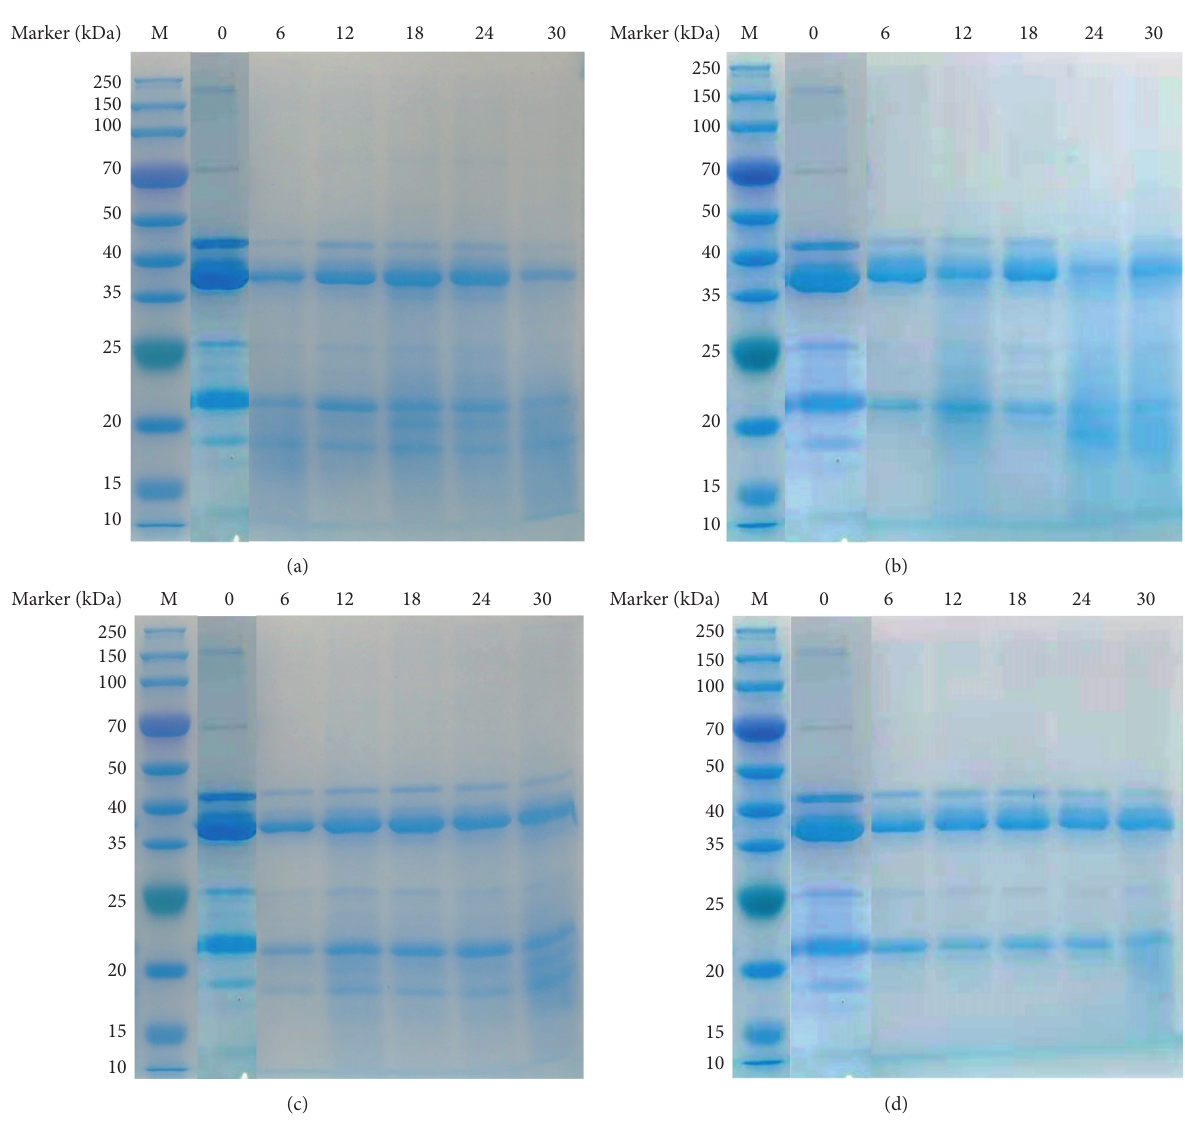
Figure 2: The SDS-PAGE pattern of dried shrimp myofibril protein during storage. (a) VP37 ° C; (b) AP37 ° C; (c) VP20 ° C; (d) AP20 °